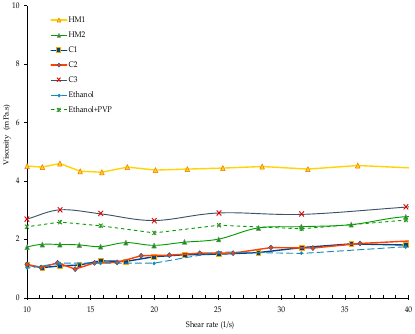
Figure 6. Viscosity vs. shear rate for the two homemade (HM) (freshly prepared) and the three commercial suspensions (as received and amended), as well as their respective base liquids.